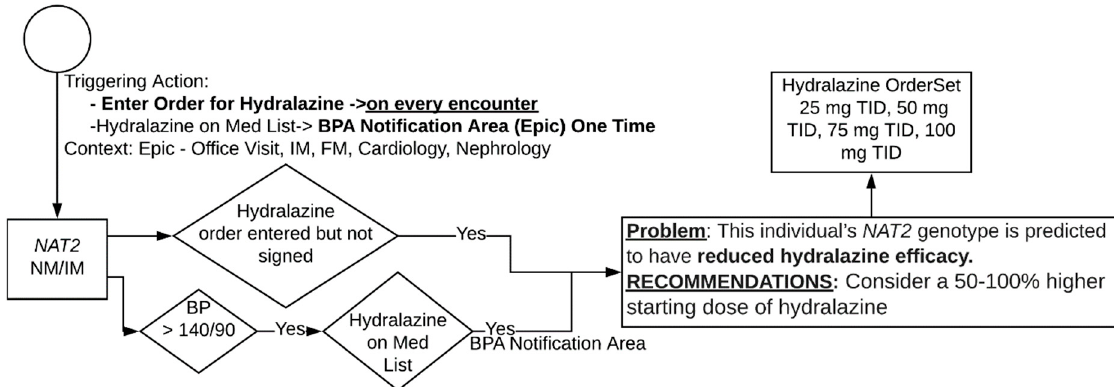
Figure A1. Proposed NAT2 algorithm for normal/intermediate metabolizers.